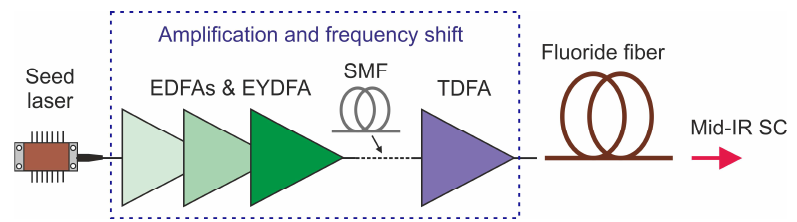
Figure 8. Schematic of the setup for SC generation based on a MOPA seeded with ~1.55 μm pulses. EDFA: erbium-doped fiber amplifier, EYDFA: erbium:ytterbium-doped fiber amplifier, SMF: single-mode (silica) fiber, TDFA: thulium-doped fiber amplifier.